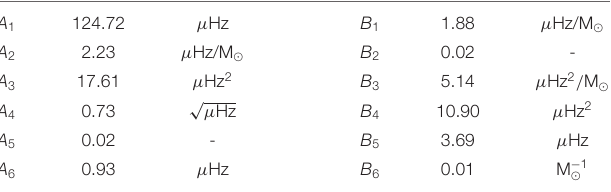
TABLE 2 | Parameters with their units of the functions in Equations (27) and